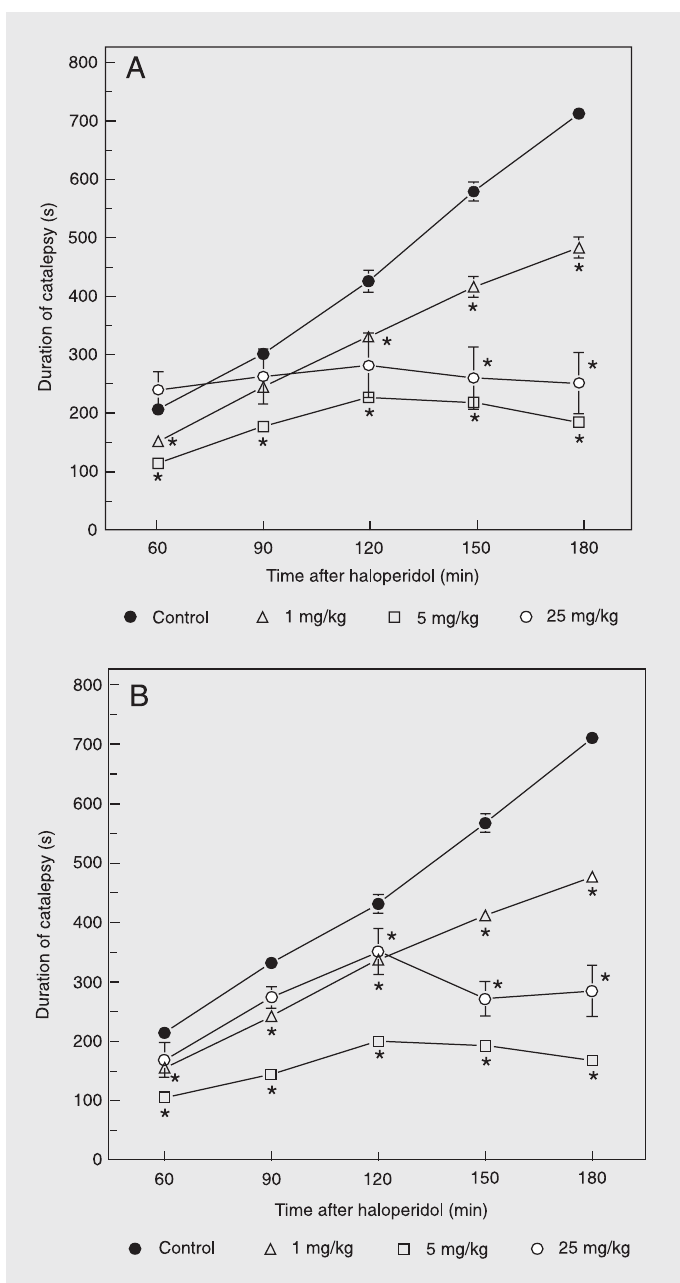
Figure 2. Effects of fluoxetine (1.0, 5.0, and 25 mg/kg, ip ) on haloperidol-induced catalepsy in male (A) and female (B) mice. Data are reported as means ± SEM for 12 mice per group. *P < 0.05 compared to vehicle (Dunnett